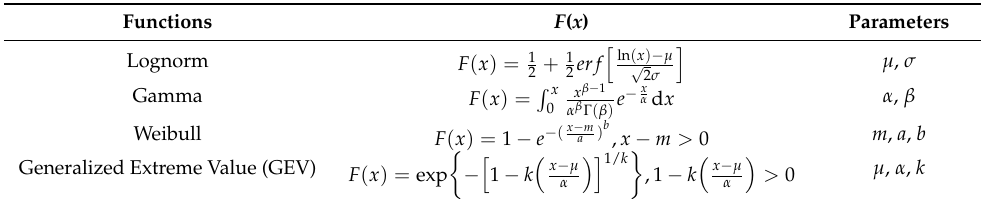
Table 2. The four commonly used univariate distribution